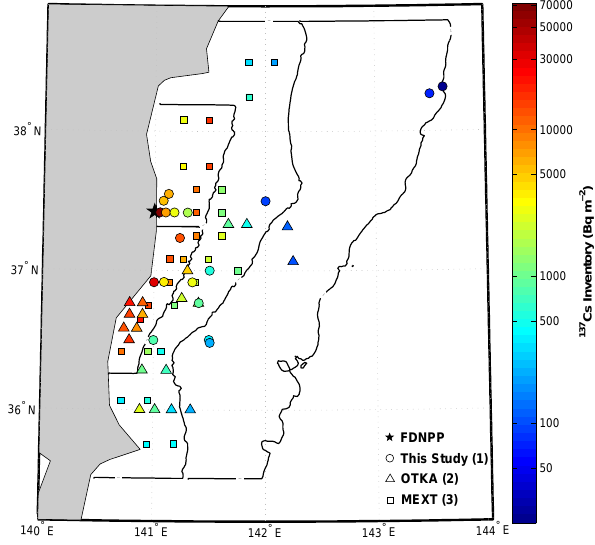
Figure 5. A compilation of sediment 137 Cs inventories from the coastal region around Fukushima, Japan. Core inventories from this study are shown as measured from May 2012 to September 2013. MEXT cores from February 2012 (Kusakabe et al., 2013) and OTKA samples from August through November of 2011 (Otosaka and Kato, 2014) were adjusted as necessary by zone to include esti- mated inventories deeper than 3 and 10cm, respectively (Sect.